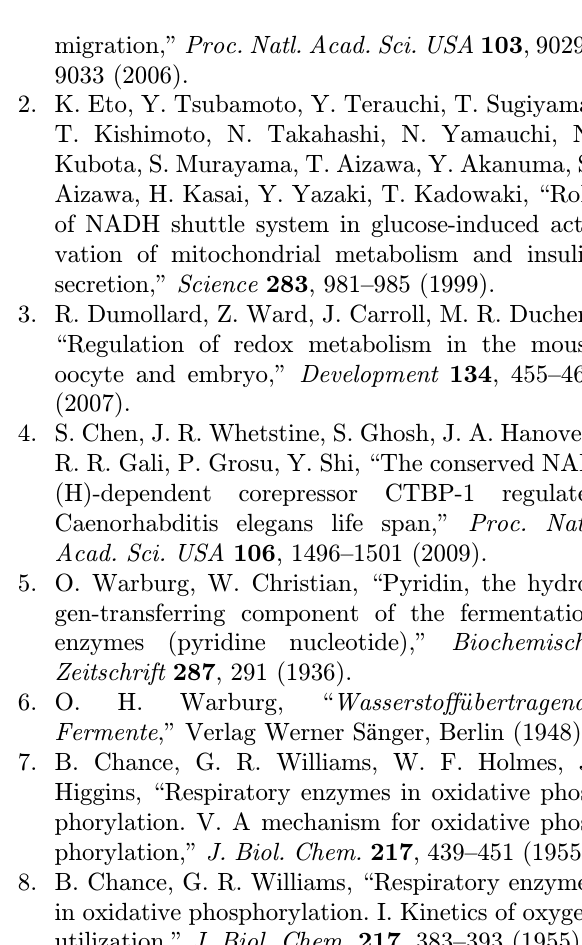
Fig. 10. Photo of Dr. Chance with other key members of the redox team (Taken after a pleasant research discussion on 7th July 2010 when Dr. Chance was approaching his 97th birthday. From back left: Lin Z. Li, He N. Xu, Jerry D. Glickson, Shoko